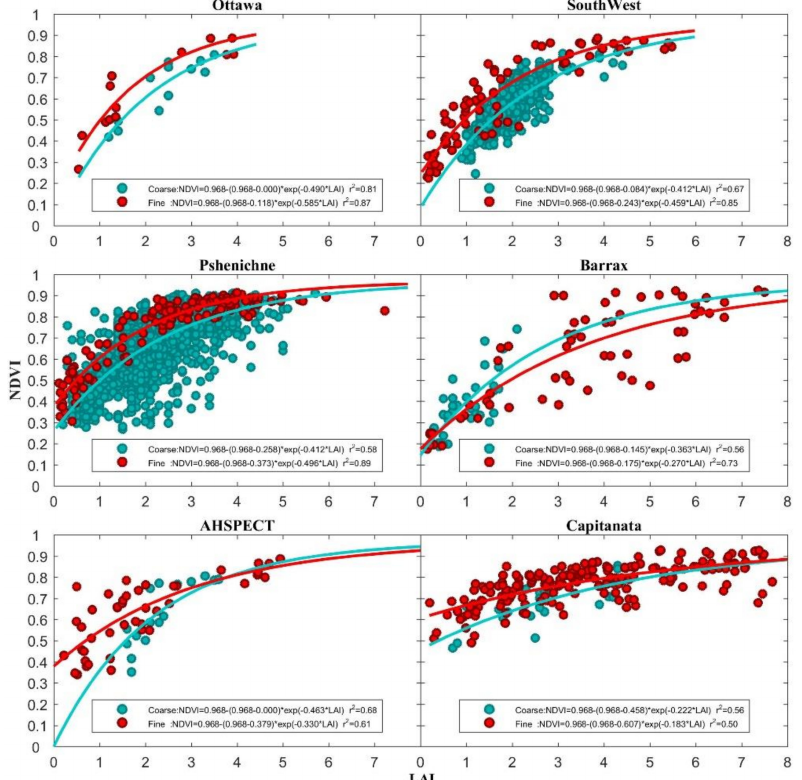
Figure 14. Semiempirical NDVI-LAI statistical model established at the two spatial resolutions (30 m and 1 km spatial resolutions) and at the six cropland sites. The red points represent the (LAI, NDVI) datasets with 30 m spatial resolutions, and the red curves represent the models f ( p ) at 30 m spatial resolutions; the aquamarine points represent the (LAI, NDVI) datasets with 1 km spatial resolutions, and the aquamarine curves represent the models F ( P ) at 1 km spatial